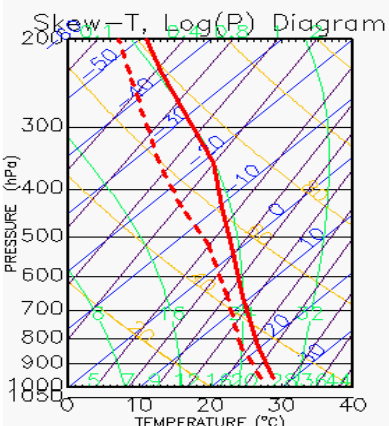
Figure 2. Skew-T – log-P diagram illustrating the initial conditions of dew point temperature (red hashed line) and atmospheric tem- perature (red solid line) used in all the three WRF-SBM idealized simulations. Blue, yellow, green, black, and purple lines indicate lines of constant temperature (isotherm), potential temperature, and equivalent potential temperature, pressure (isobar), and saturation mixing ratio,